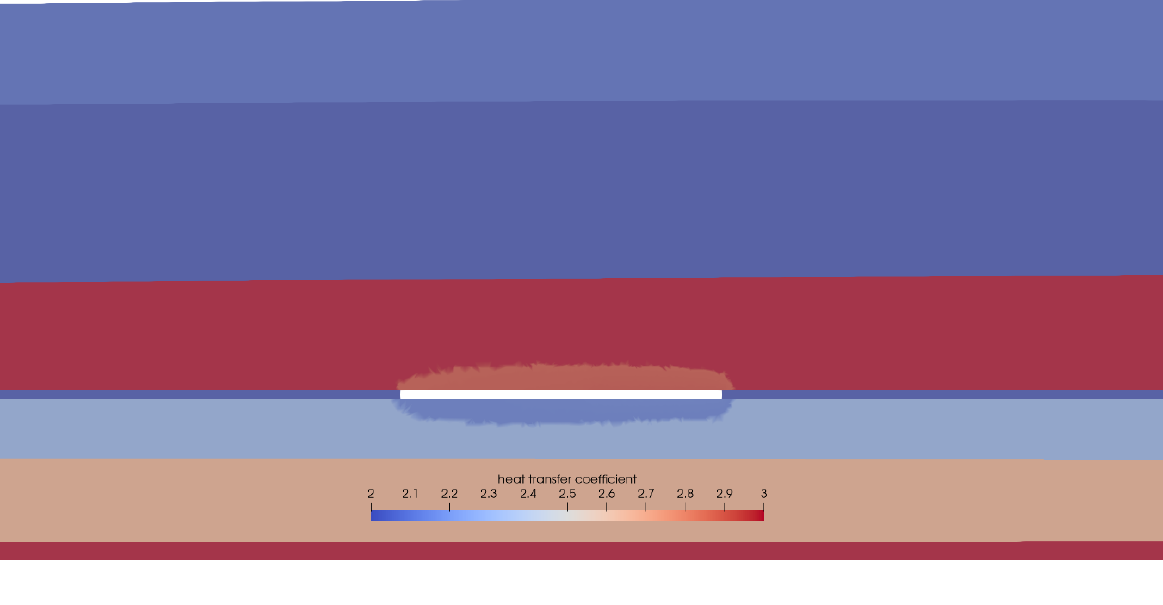
Figure 14: Heat transfer coefficient (W/m/K) at t = 1 year: cross-section y = 750 m, close-up of gasification